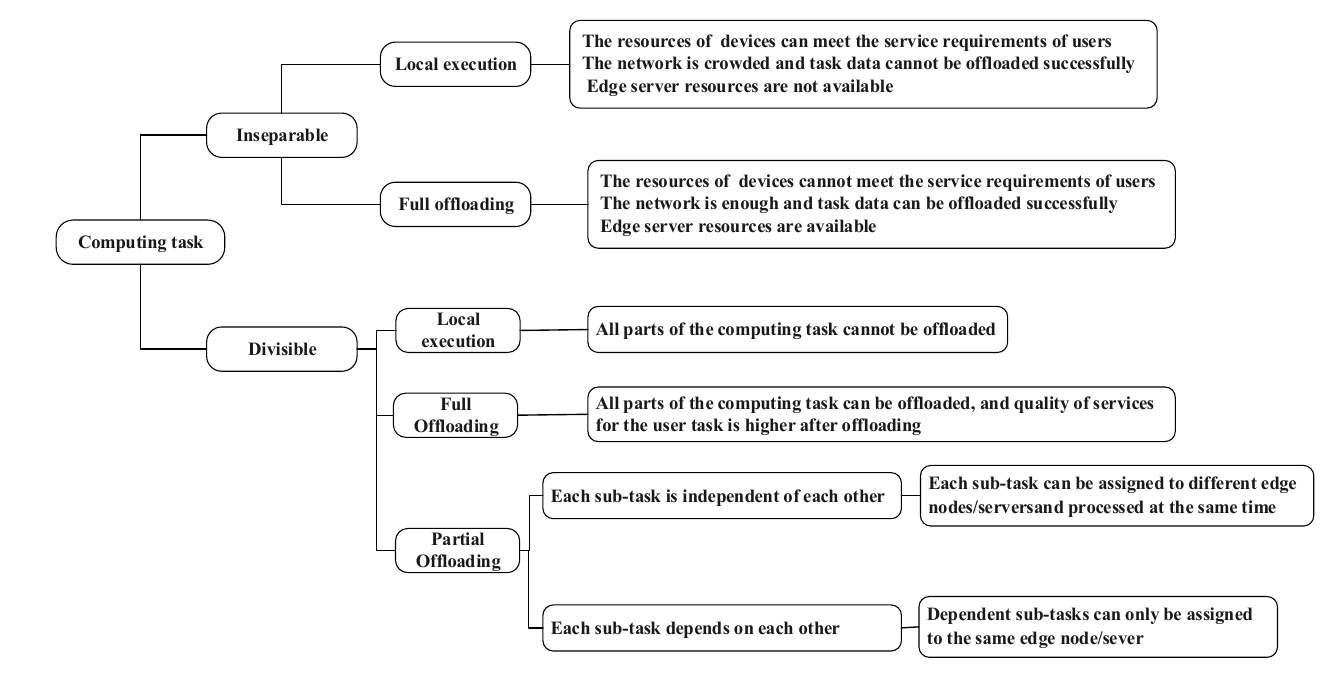
Figure 6. Computing task analysis and execution.